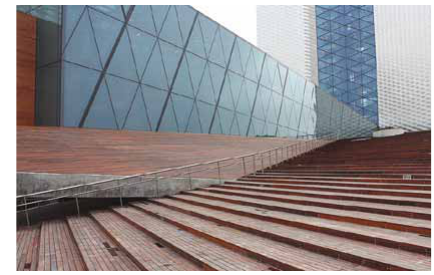
Fig. 3. Wooden platforms in the beach, Fig. 4. Bank building in Vilnius, archit.